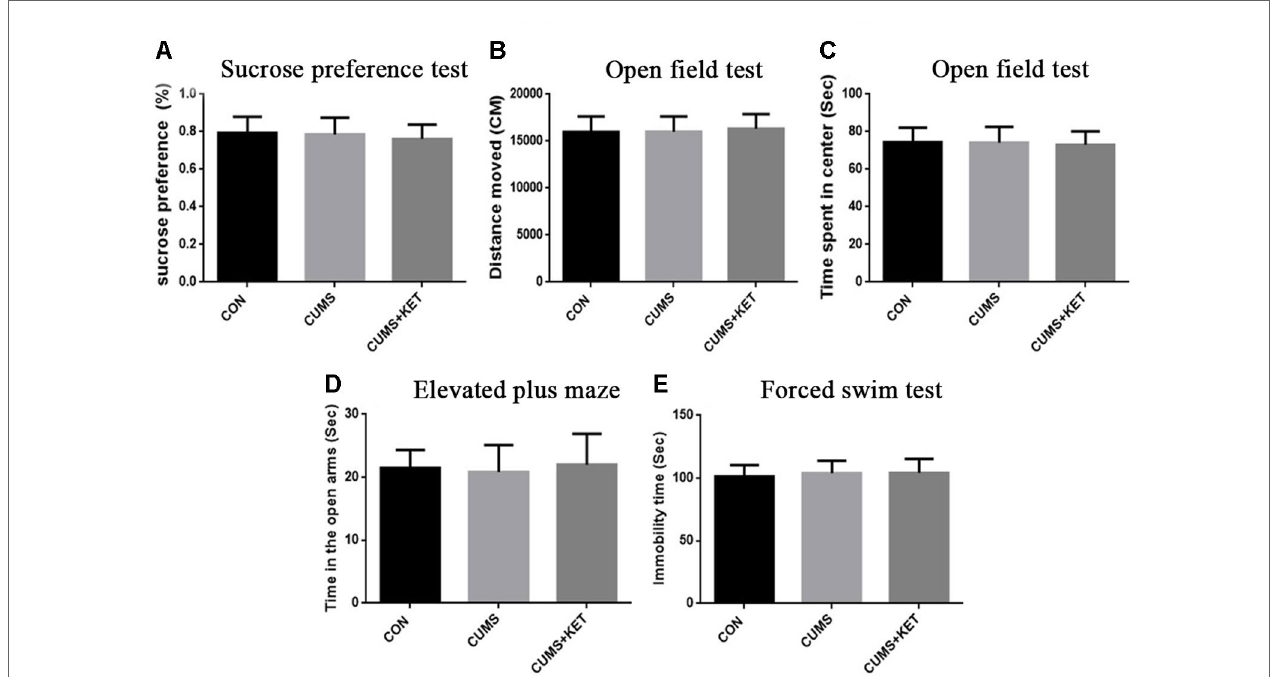
FIGURE 3 | Effects of CUMS on the anhedonia, anxiety, and depression-like behaviors for Tau KO mice. (A) Preference for the sucrose solution on the sucrose- preference test. (B) Total distance traversed in the open-field test. (C) Time spent in the center area of the open-field test. (D) Time in the open arms of the elevated plus-maze. (E) Duration of immobility in the forced-swim test. Data are expressed as mean ± SD; n = 21 per group. One-way ANOVA was used to compare difference among the CON, CUMS, and CUMS+KET